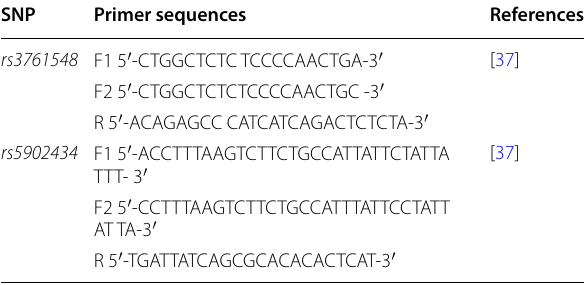
Table 1 Primers sets used for SNP genotyping analyses